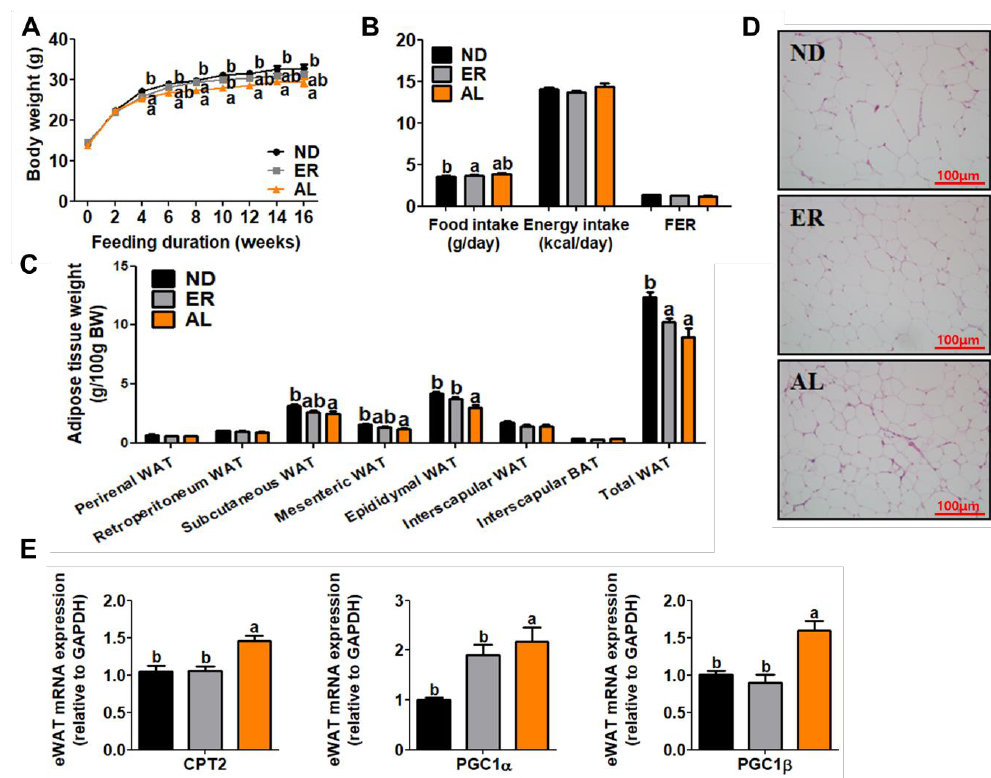
Figure 1. Effect of AL supplementation for 16 weeks on: body weight ( A ), food efficiency ratio (FER) ( B ), adipose tissue weight ( C ), epdidymal white adipose tissue morphology (200× magnification) ( D ) and mRNA expression ( E ). Data are mean ± S.E. a b Means values with unlike superscript letter are